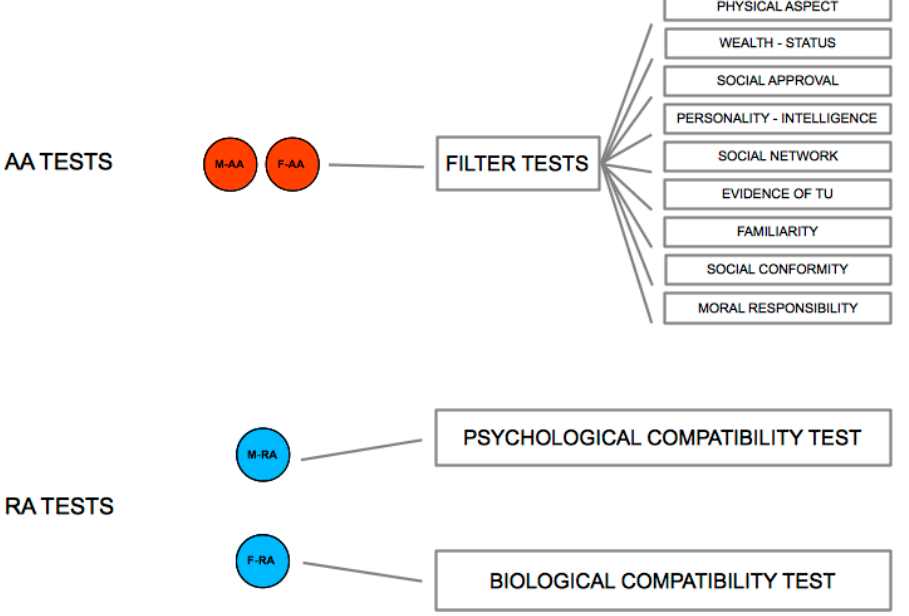
Figure 2. Tests carried out by the AAs and RAs on potential opposite-sex partners. Active Areas are in red, Receptive Areas in blue.